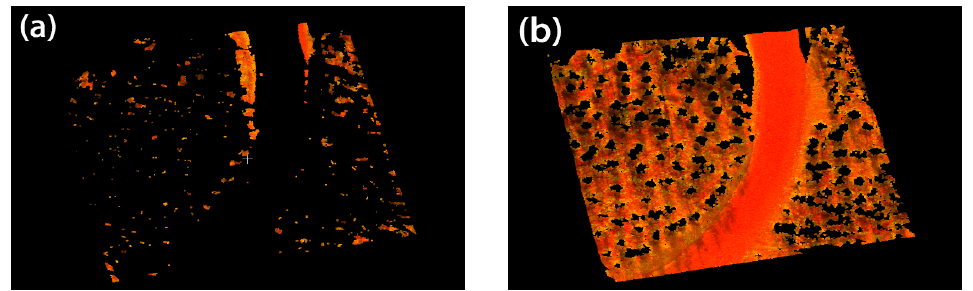
Figure 26. The segmentation results of the point clouds of Figure 22b with CSF : ( a ) is the removed points; ( b ) is the remaining